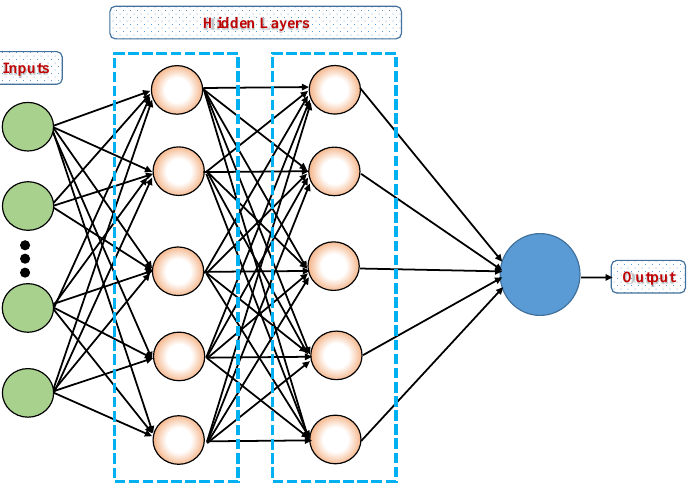
Figure 1. Simple architecture of artificial neural network comprising multiple layers (input, hidden, and output